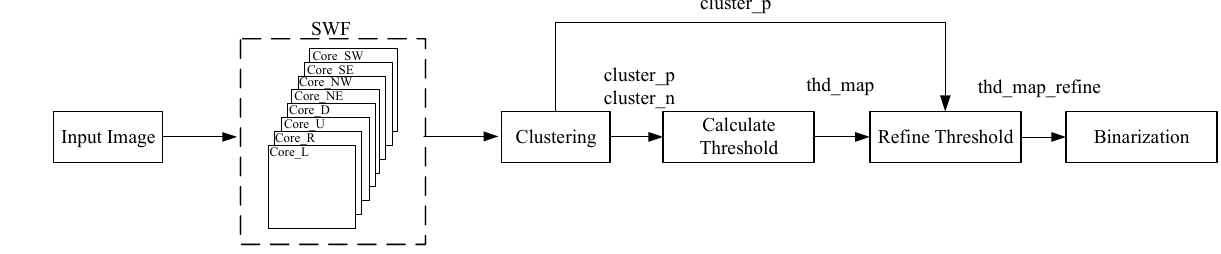
Figure 9. Flow chart of the proposed algorithm.